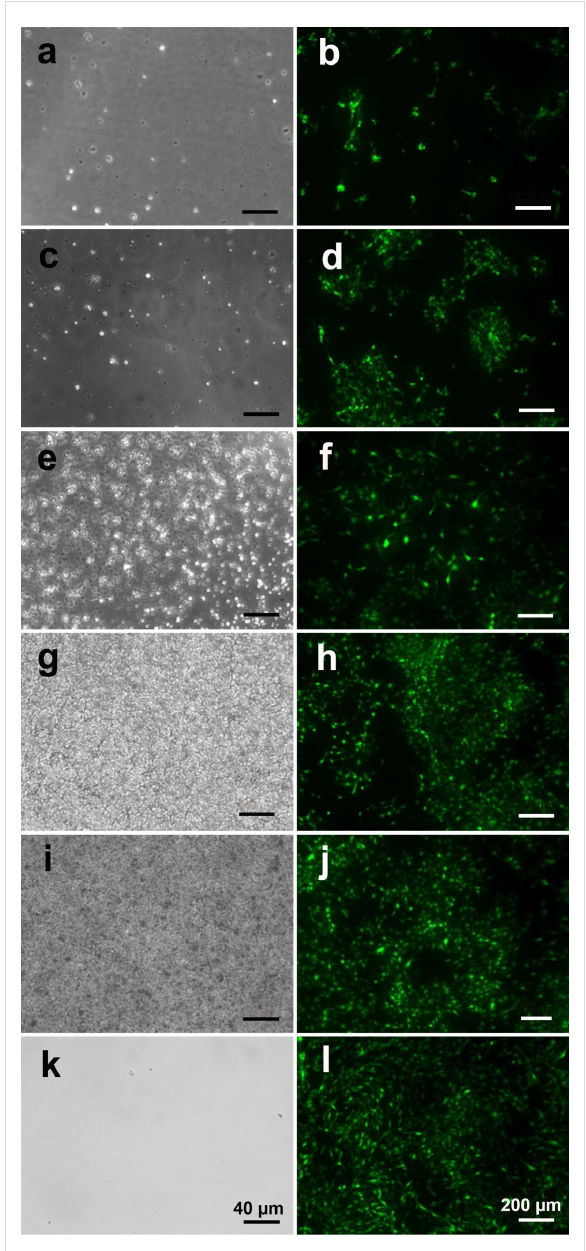
Figure 4: Porcine aortic endothelial cells cultured on GaN-functionali- zed glass coverslips. (a,c,e,g,i) Coverslips coated with silicone and treated with 0, 0.5, 5, 50, or 250 µg/cm 2 GaN nanoparticles, respec- tively. (b,d,f,h,j) The GFP labeled porcine endothelial cells cultured on the 0, 0.5, 5, 50, or 250 µg/cm 2 GaN-functionalized surfaces. (k,l) Cells seeded on uncoated, untreated glass coverslips.